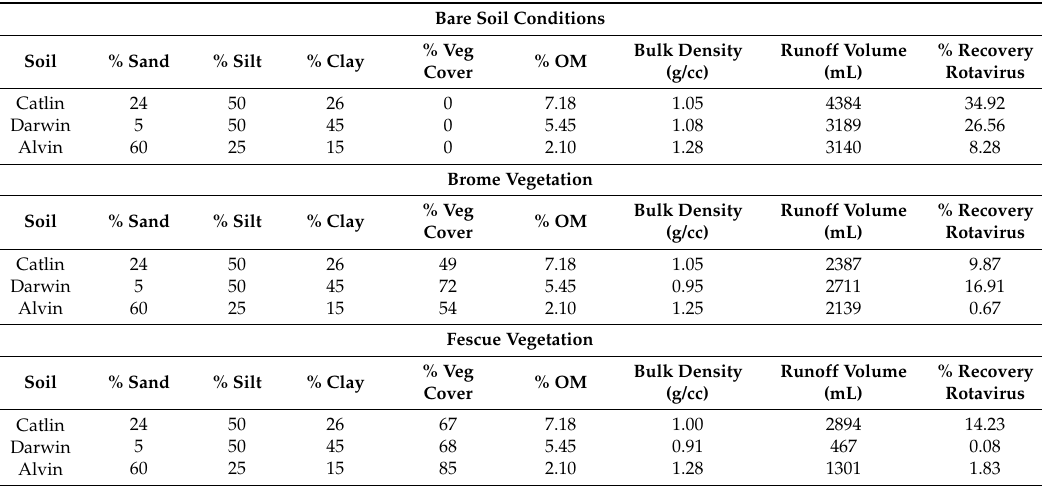
Table 2. Summary of infective rotavirus particles recovered from surface runoff tabulated in conjunction with the seven experimental parameters collected for each combination of soil and vegetation type. Bare Soil